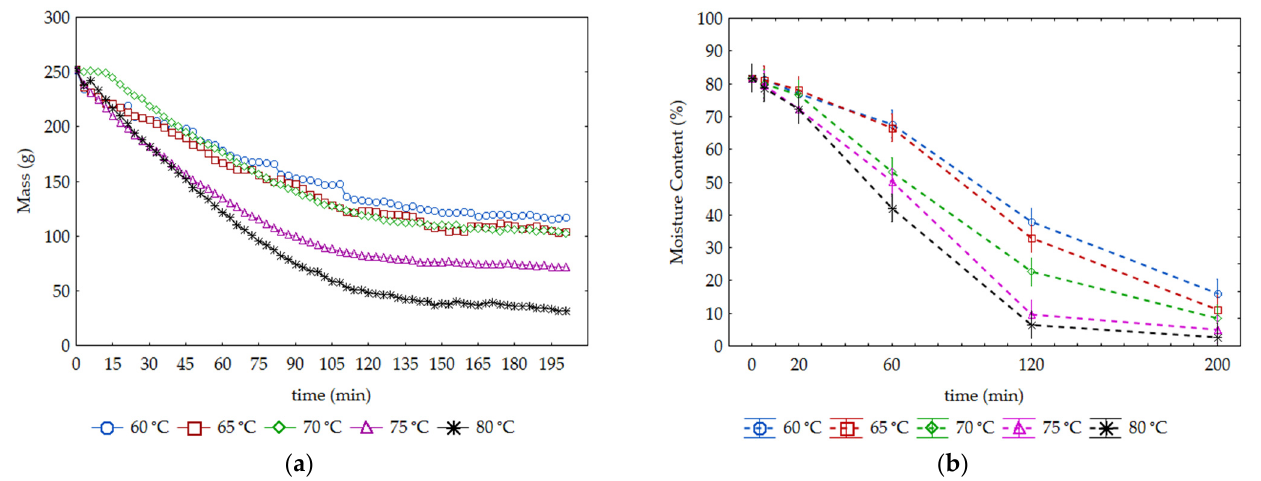
Figure 1. Effect of drying temperature on mass loss (g) ( a ) and variation of moisture content (%) ( b ) of SP samples with time . Vertical bars denote 0.95 confidence intervals.